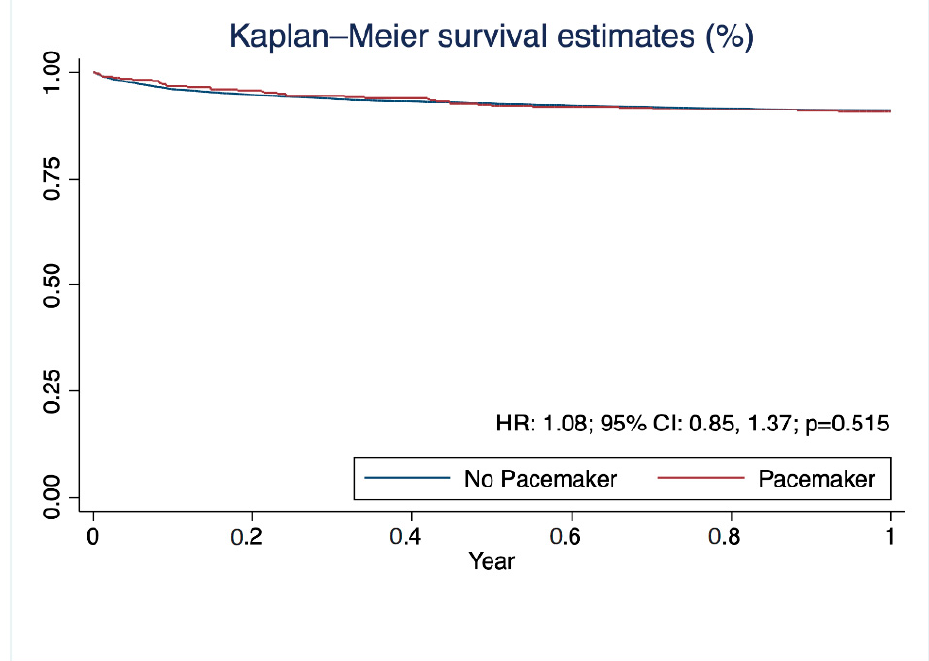
Figure 2. Kaplan–Meier curves showing 1-year survival post heart transplantation according to the need for pacemaker implantation.